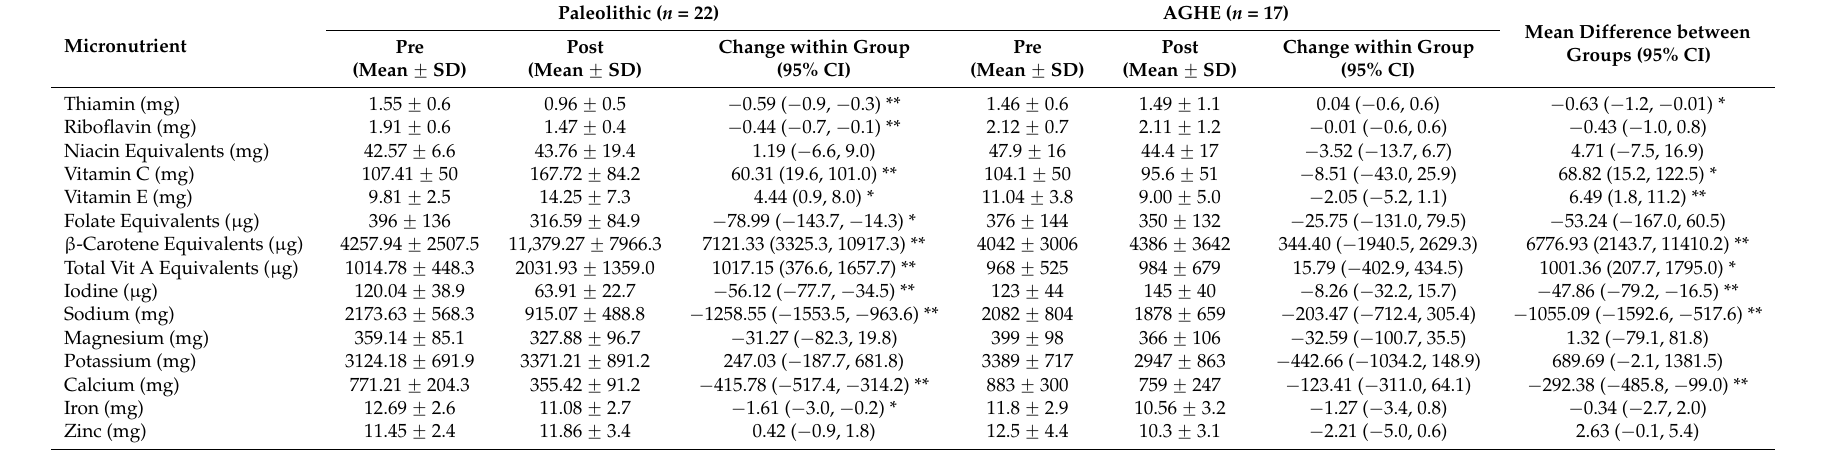
Table 4. Mean pre and post intervention daily micronutrient intake, showing mean changes within and between groups 1 .